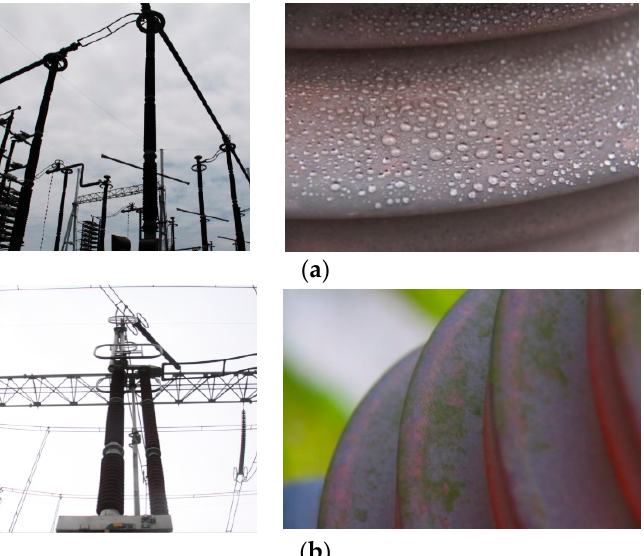
Figure 4. The DC/AC pillar insulators of the DYS converter station. ( a ) DC pillar insulator. ( b ) AC pillar insulator.